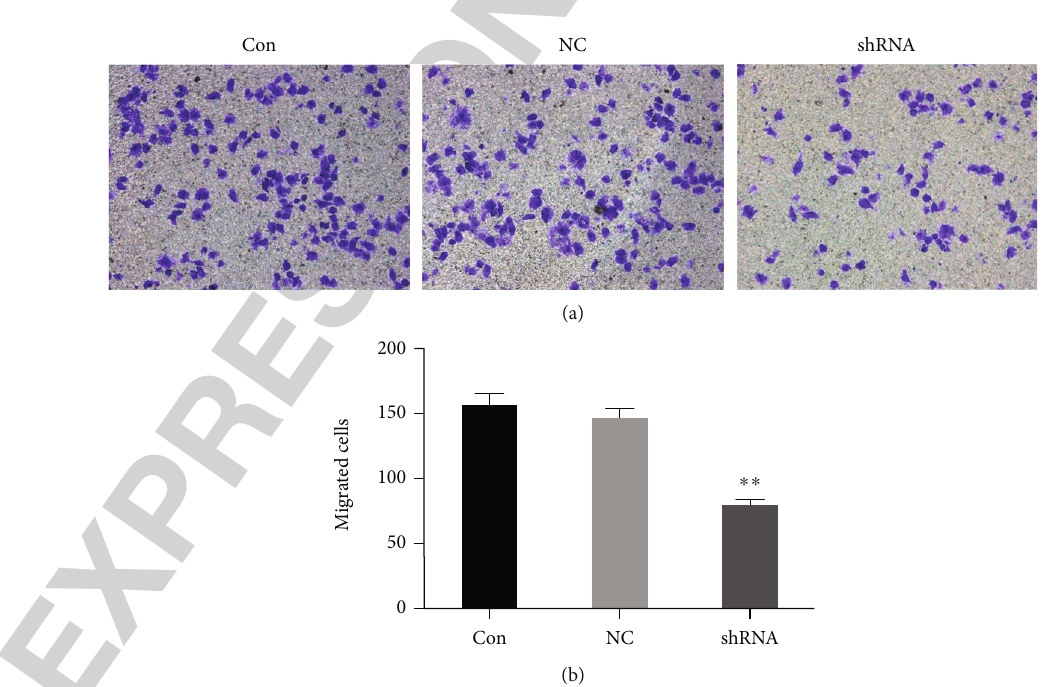
Figure 4: LOXL1-AS1 knockdown suppressed migration in the liver cancer cell line. (a) Representative pictures of crystal violet-stained Hep- G2 cells migrated through the polycarbonate membranes. (b) Statistical plot of the average number of migrated Hep-G2 cells in all three groups. Graph revealed mean ± SD , ∗∗ meant P < 0 : 01